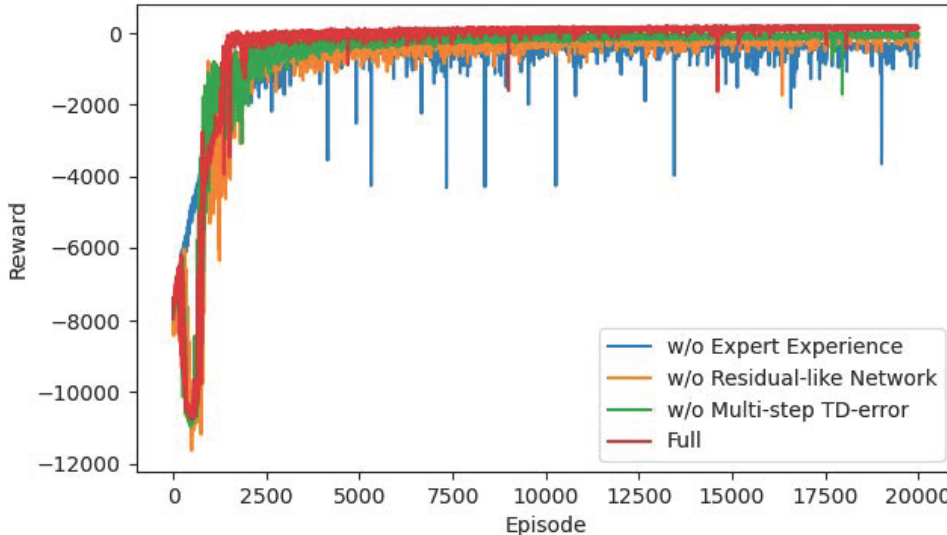
Figure 15. The reward curves in the ablation experiment.